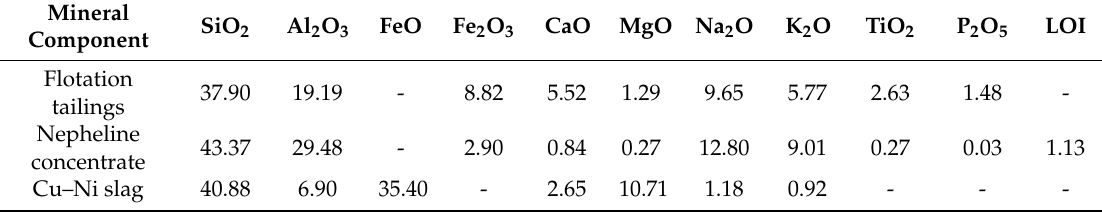
Figure 1. The flotation tailings dumps of apatite-nepheline dressing plant ANDP-2 of Joint-stock company “Apatit”. Reproduced with permission from V.V. Petkevich. Table 2. Chemical composition of the flotation tailings of apatite–nepheline dressing plant ANDP-2, nepheline concentrate, and Cu–Ni slag (wt. %).